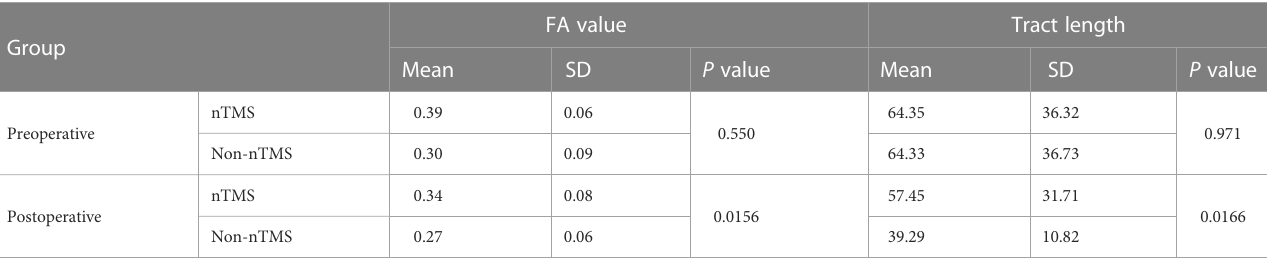
TABLE 2 Analysis of fi ber-tracking results between nTMS and non-nTMS. Group